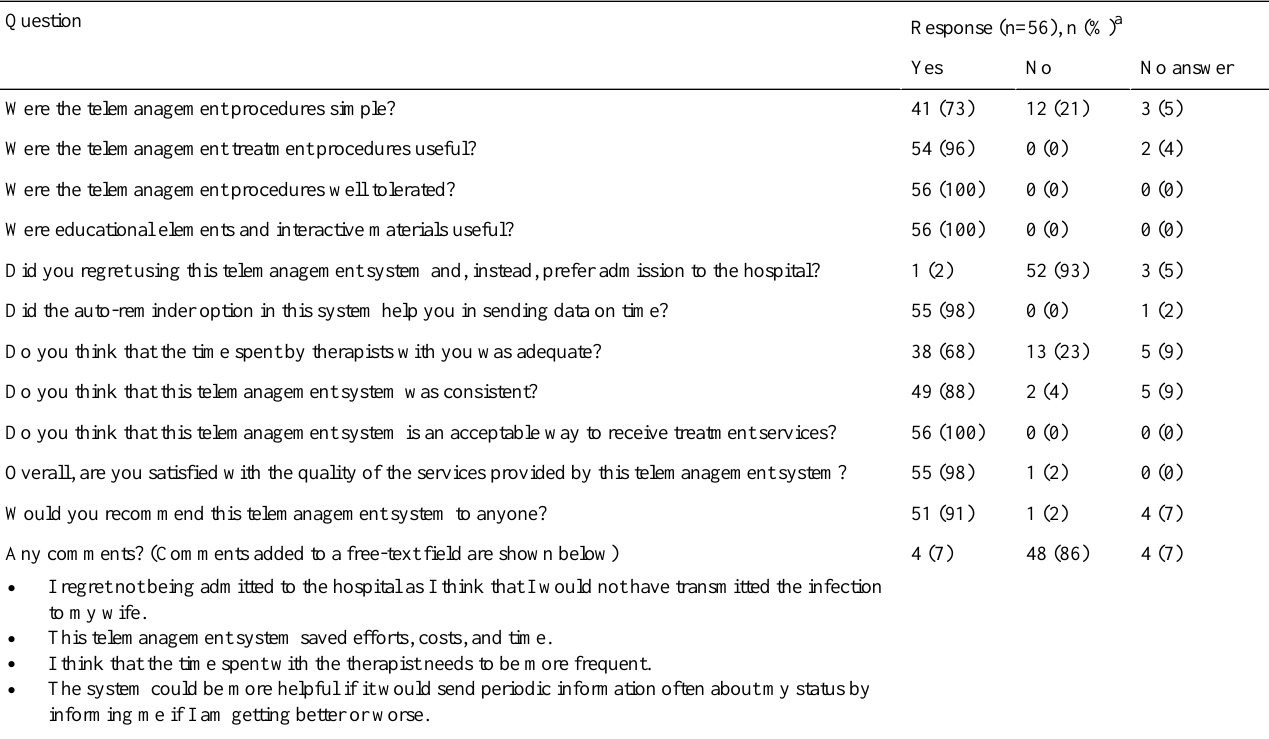
Table 3. Posttreatment patient satisfaction questions for the telemanagement